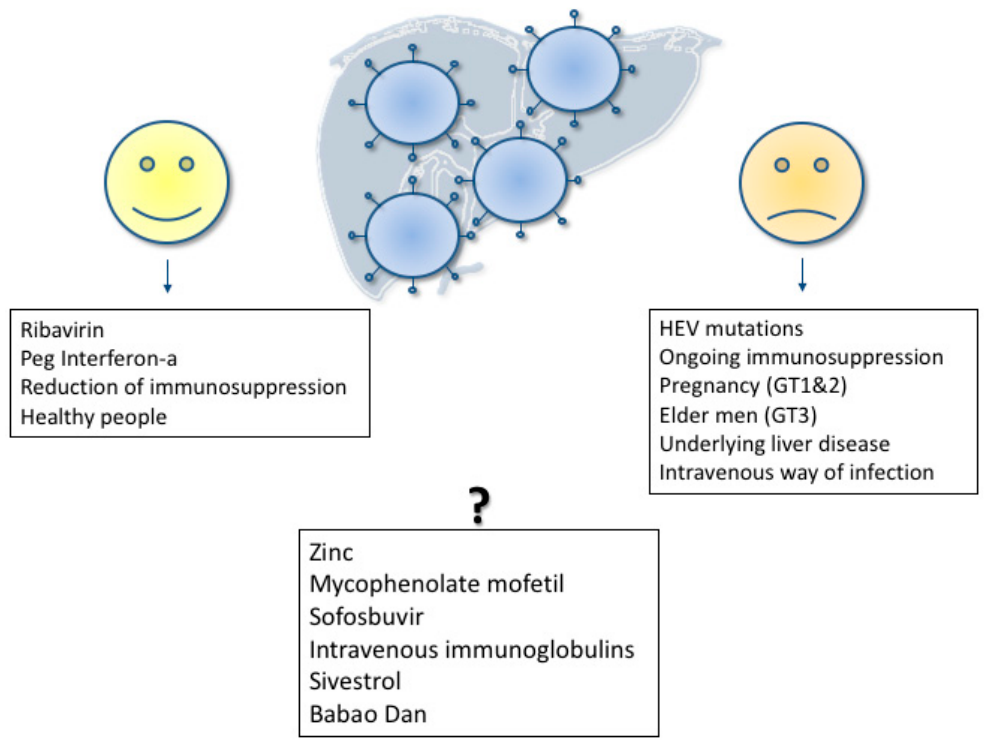
Figure 2. Different factors influencing HEV infection: Protective and beneficial factors on the left hand; unfavorable and risk factors on the right hand; not yet clarified factors in the lower middle.